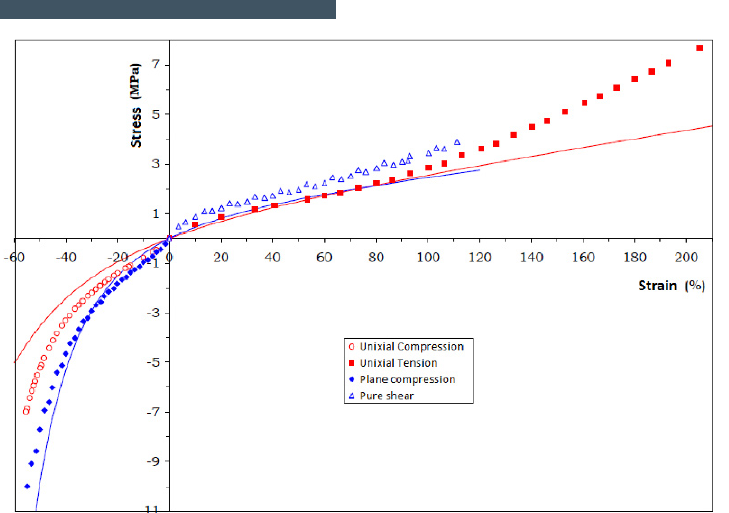
Figure 8. Hyperelastic response of tire rubber.